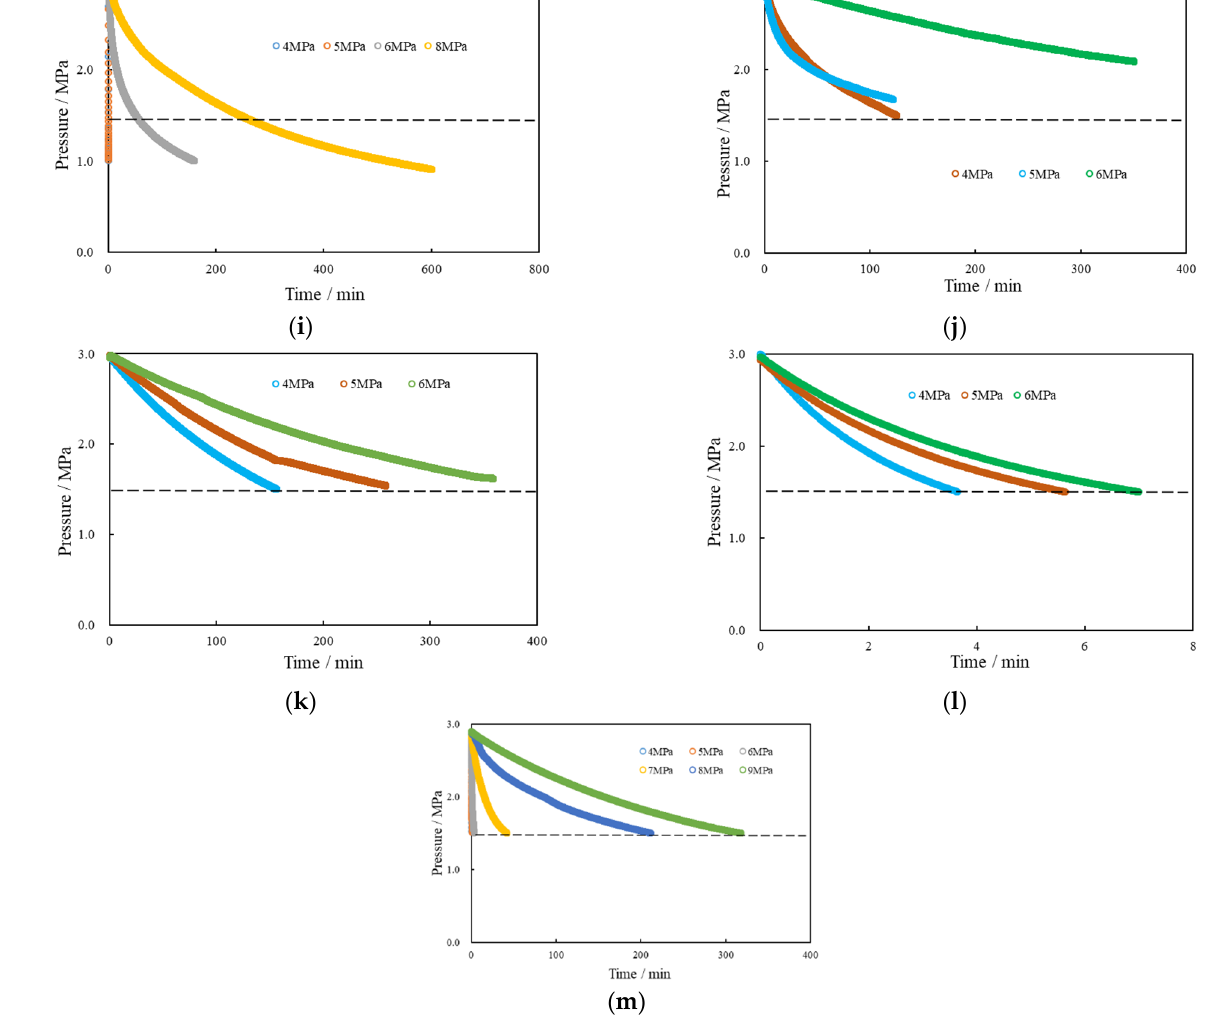
Figure 7. Pressure evolution. ( a ) sample L-1; ( b ) sample L-2; ( c – g ) samples Y-1 to Y-5; ( h – l ) samples M-1 to M-5; ( m ) sample C-1.